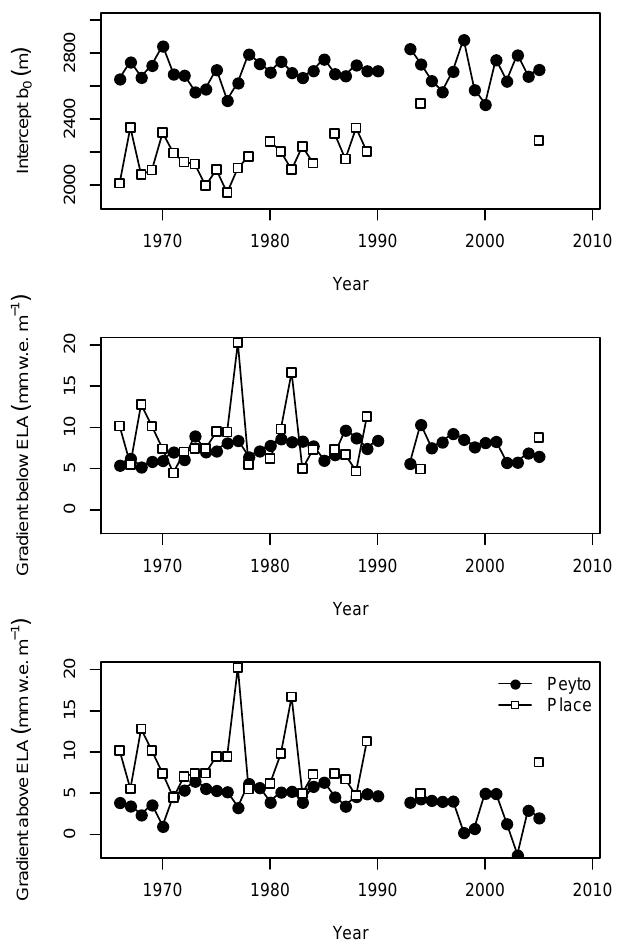
Fig. 12. Time series of fitted mass balance coefficients for Peyto and Place